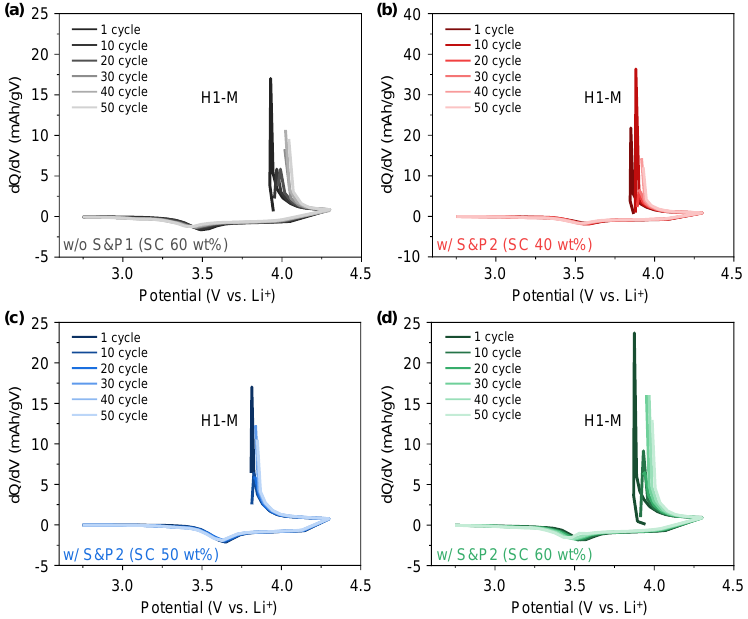
Figure 6. dQ/dV analysis for the cycle charge − discharge of cells containing ( a ) without S&P1 (SC 60 wt%), ( b ) with S&P2 (SC 40 wt%), ( c ) with S&P2 (SC 50 wt%), and ( d ) with S&P2 (SC 60 wt%) at 5C.